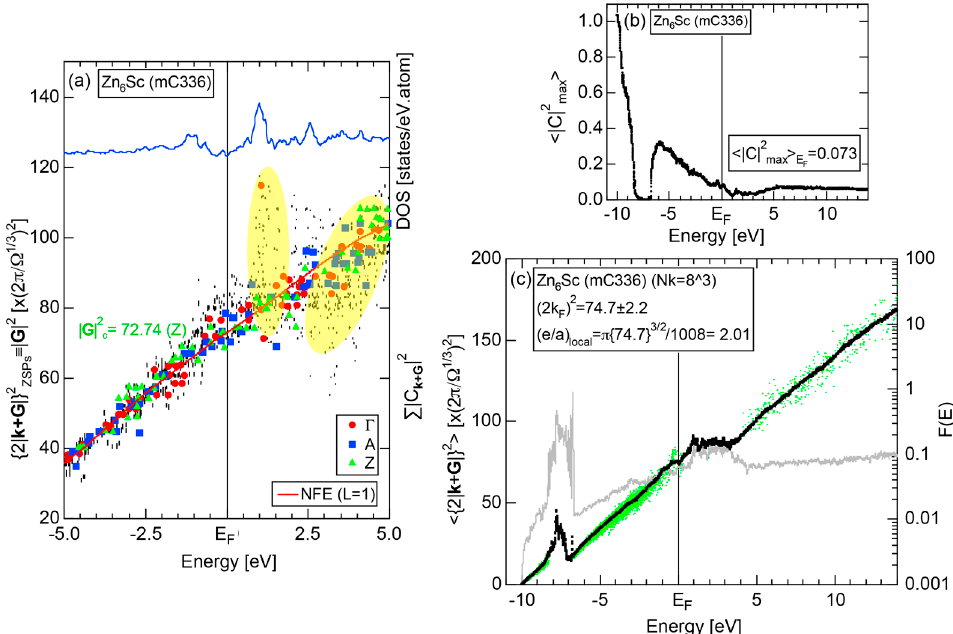
Figure 48. ( a ) FLAPW-Fourier spectra at symmetry points Γ , A, Z of the Brillouin zone of monoclinic lattice; ( b ) and ( c ) Hume-Rothery plot for Zn 6 Sc (mC336) [11,50]. Formation of bonding and anti-bonding states due to Sc-3d-states-mediated splitting in ( a ) is highlighted by yellow color. A blue curve in ( a ) indicates the total-DOS.